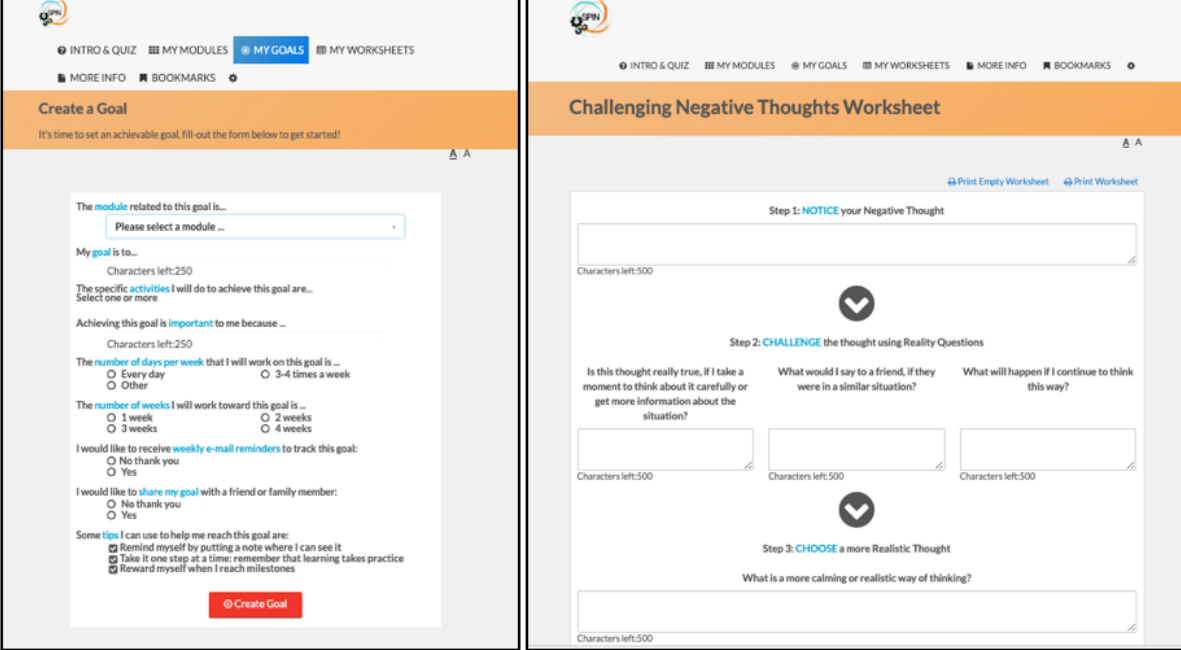
Figure 6. Tools to support key components of successful self-management programs, including goal-setting strategies, goal forms, and worksheets to learn how to integrate newly learned skills and techniques into a daily routine.